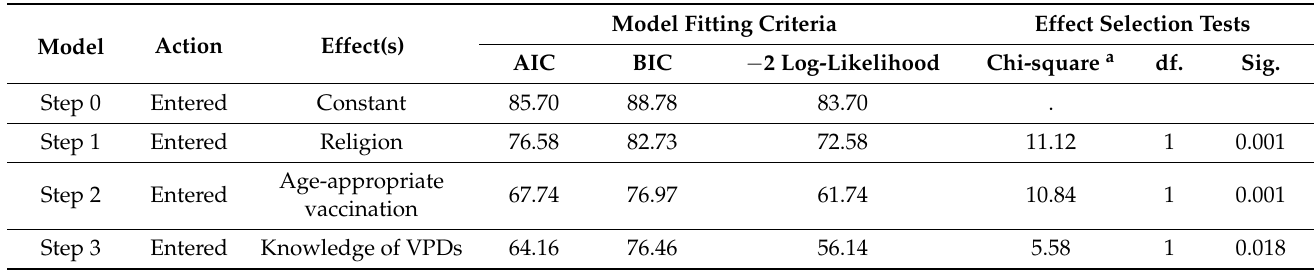
Table 4. Information criteria of multivariate logistic regression analysis of vaccination decision- making in parents with children between 12 to 23 months ( n = 160).